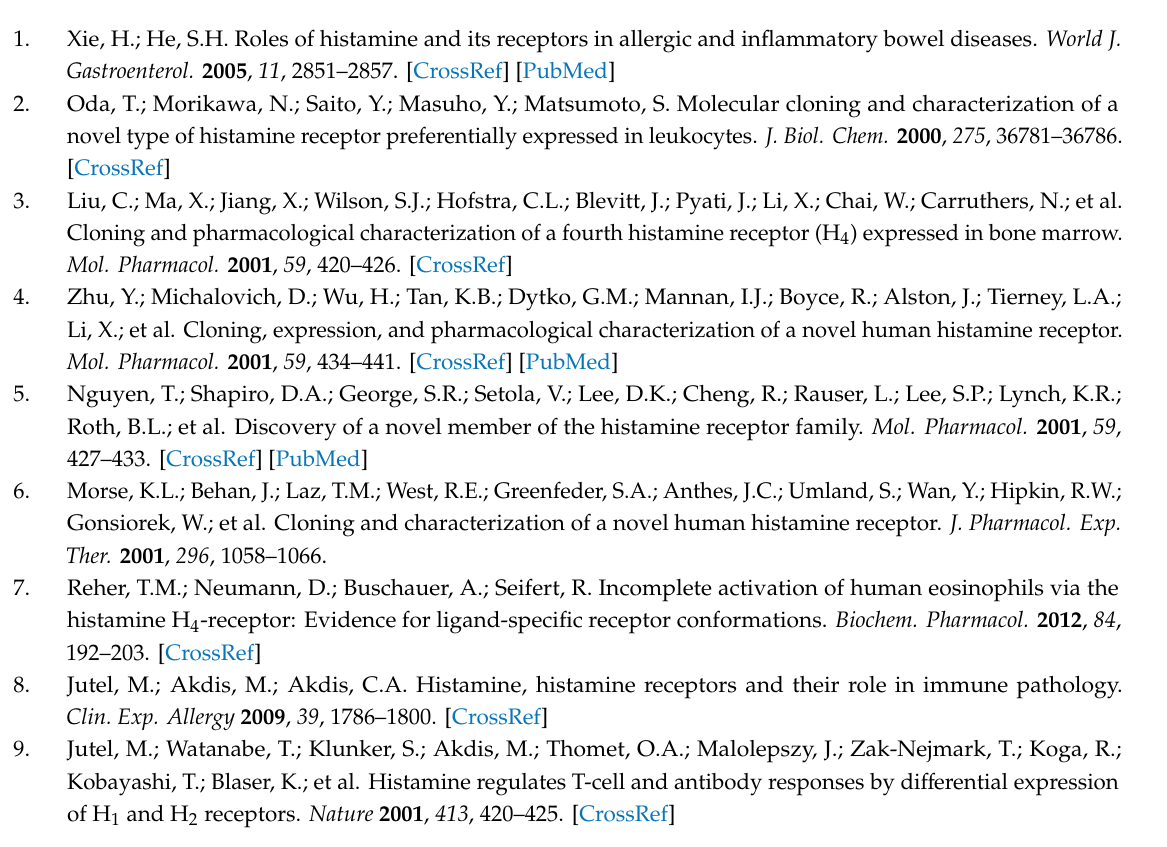
Figure S1: Colon tissues prepared out of the mice described in Figure 1 were fixed in bu ff ered formalin, embedded in para ffi n, and sliced into histological sections. Sections were stained for either CD 3 (Dako, Code A 0452, Copenhagen, Denmark) or CD 22 (Zytomed Systems Cat.-No 503, Berlin, Germany) and counterstained with haemalaun. Shown are representative photographs of the immunohistochemical analyses. WT: wild type, TM: H 4 R − / − , ctr: AOM-treated mice, CRC: AOM / DSS-treated